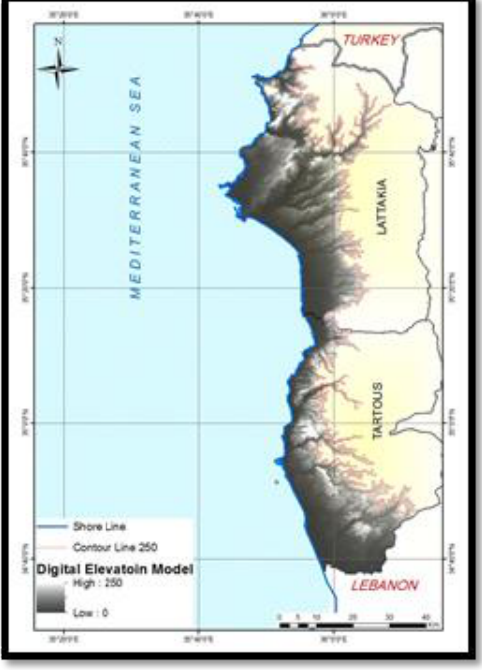
Figure 1: The preparation of the student on the basis of satellite image. The ability of discrimination